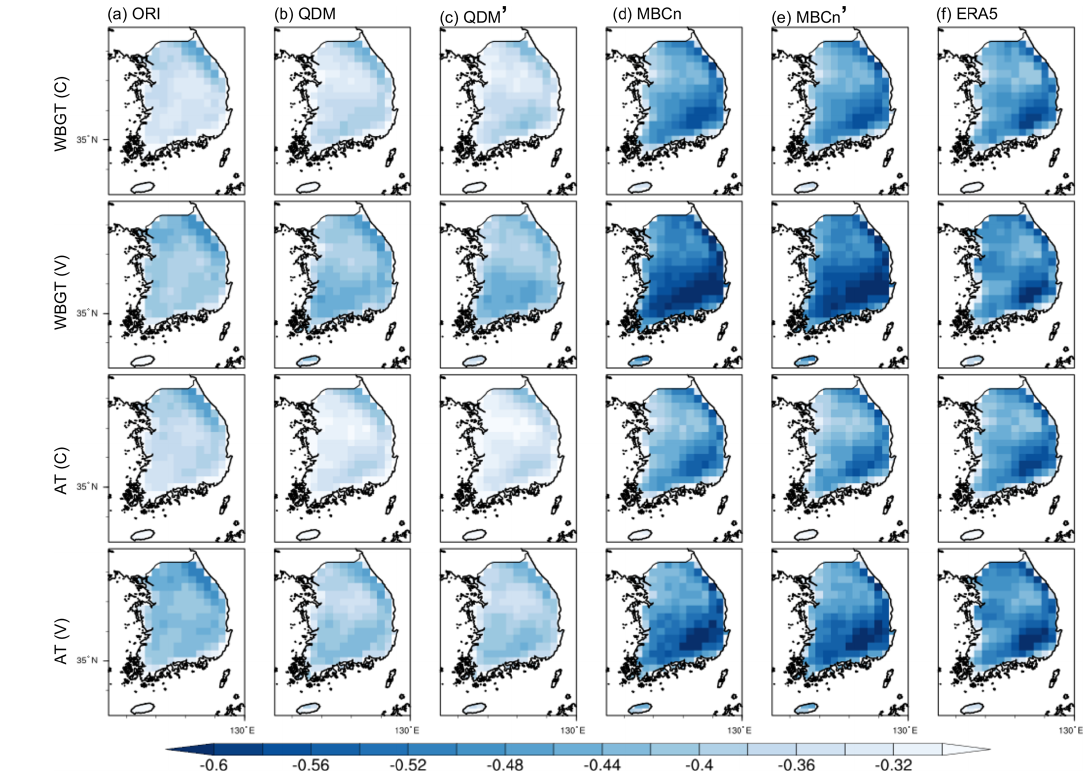
Figure 8. Spatial patterns of T vs. RH Spearman’s rank correlation ( α = 001) computed in each grid cell during the calibration (rows 1 and 3) and validation (rows 2 and 4) period. Column (a) shows the results from ORI simulations. Columns (b) and (d) are the heat-stress indices directly corrected by QDM and MBCn. Columns (c) and (e) are the heat-stress indices indirectly corrected by QDM and MBCn. Column (f) is from